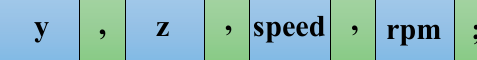
Figure 6 . Data packet template.